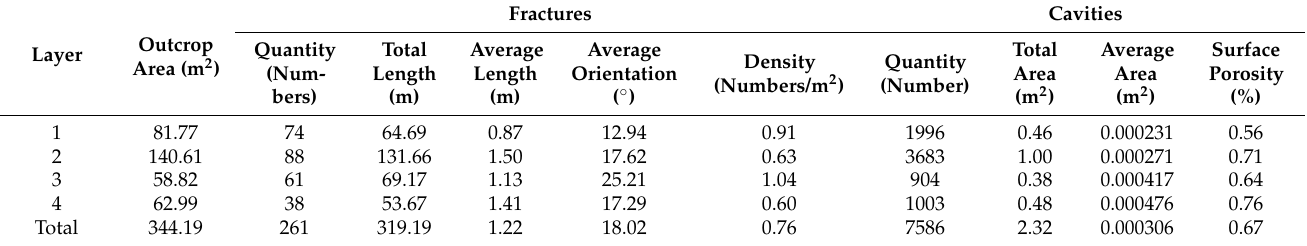
Table 1. Statistics of fracture-cavity characteristic parameters of the Dengying Formation (second